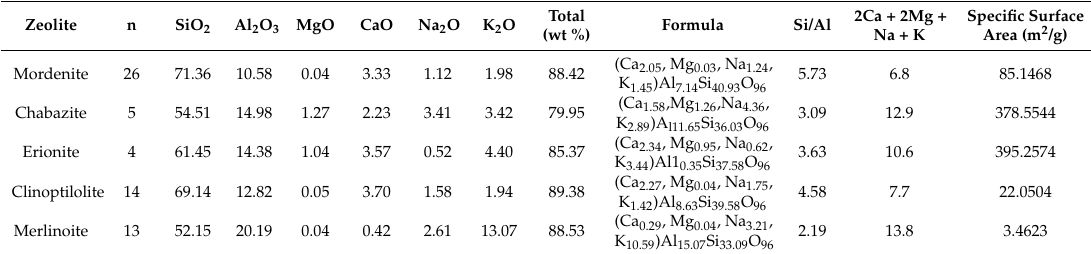
Table 1. Weight percentages of the chemical composition of zeolites by EPMA (n: analytic grain numbers; Si/Al and 2Ca + Mg + Na + K based on 96 oxygen in molar ratio). Specific surface area was determined by the BET